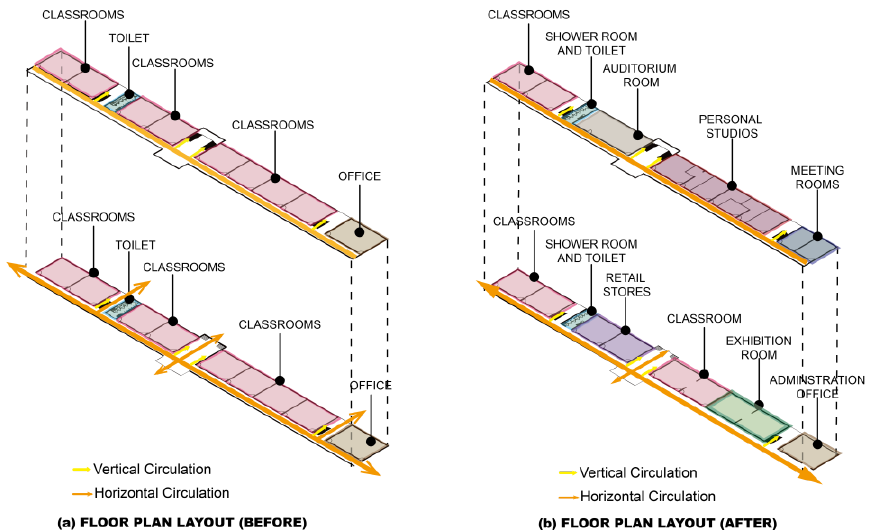
Figure 5. Floor Plans: ( a , b ) Checheng Elementary School Wencyuan Branch Floor Plans.